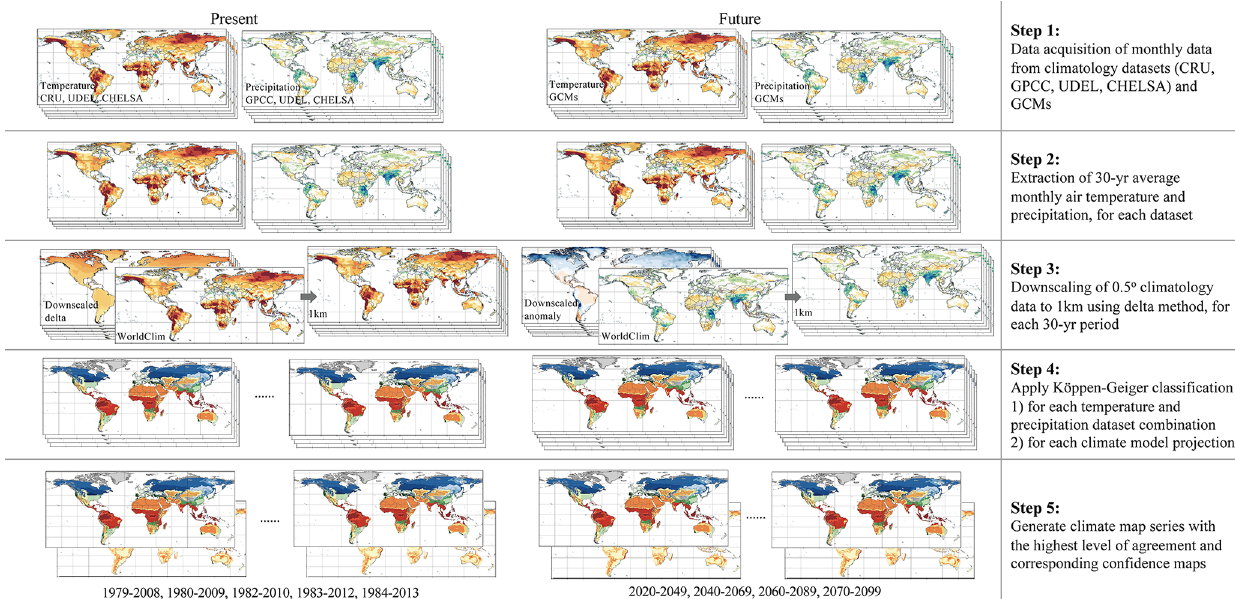
Figure 2. Step-by-step process to generate Köppen–Geiger climate map